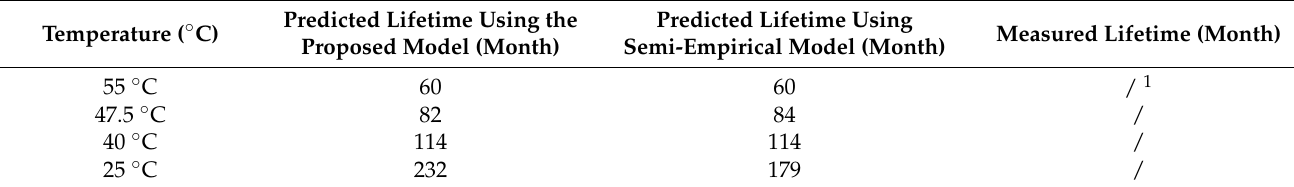
Figure 23. Comparison of modeling results for temperature dependence of resistance increase (at 50% SOC level). Table 8. Comparison of the lifetime prediction results between the proposed resistance increase model and the semi- empirical model (Only the effect of storage time and temperature is considered; when 20% capacity fade EOL criterion has been reached, SOC level is fixed to 50%).